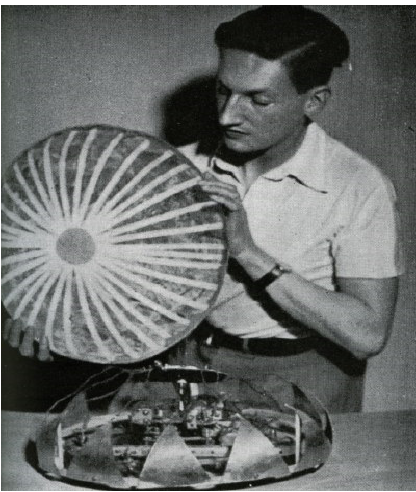
Figure 3. An image of Albert Ducrocq and his robot Miso-1 in 1950s [8].